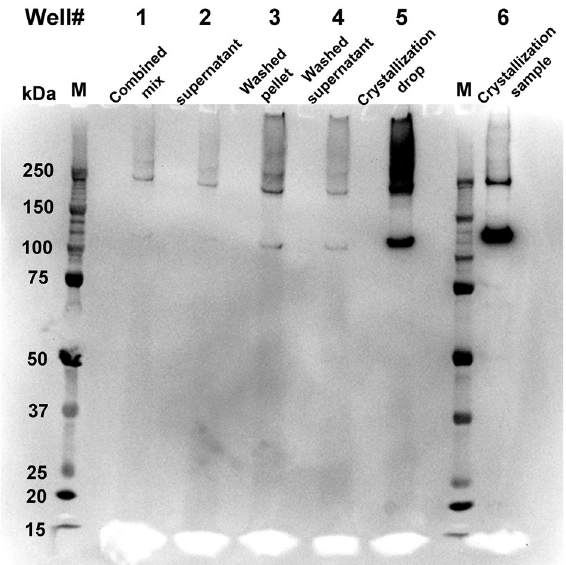
Figure 5. Presence of pGC-A in crystals was confirmed via western blot. The anti-pGC-A antibody was used in the western blot. The pGC-A monomer is 120 kDa. Lane 1: combined mix: combined crystallization drops collected in the PCR tube. Lane 2: supernatant: the supernatant collected from the centrifuged combined mix. Lane 3: washed pellet: the crystal pellet was washed with the precipitant solution and collected again via centrifugation. Lane 4: washed supernatant: the supernatant from washed crystal pellet. Lane 5: crystallization drop: one crystallization hanging drop directly mixed with SDS sample buffer. Lane 6: crystallization sample: purified pGC-A before crystallization, serving as a positive